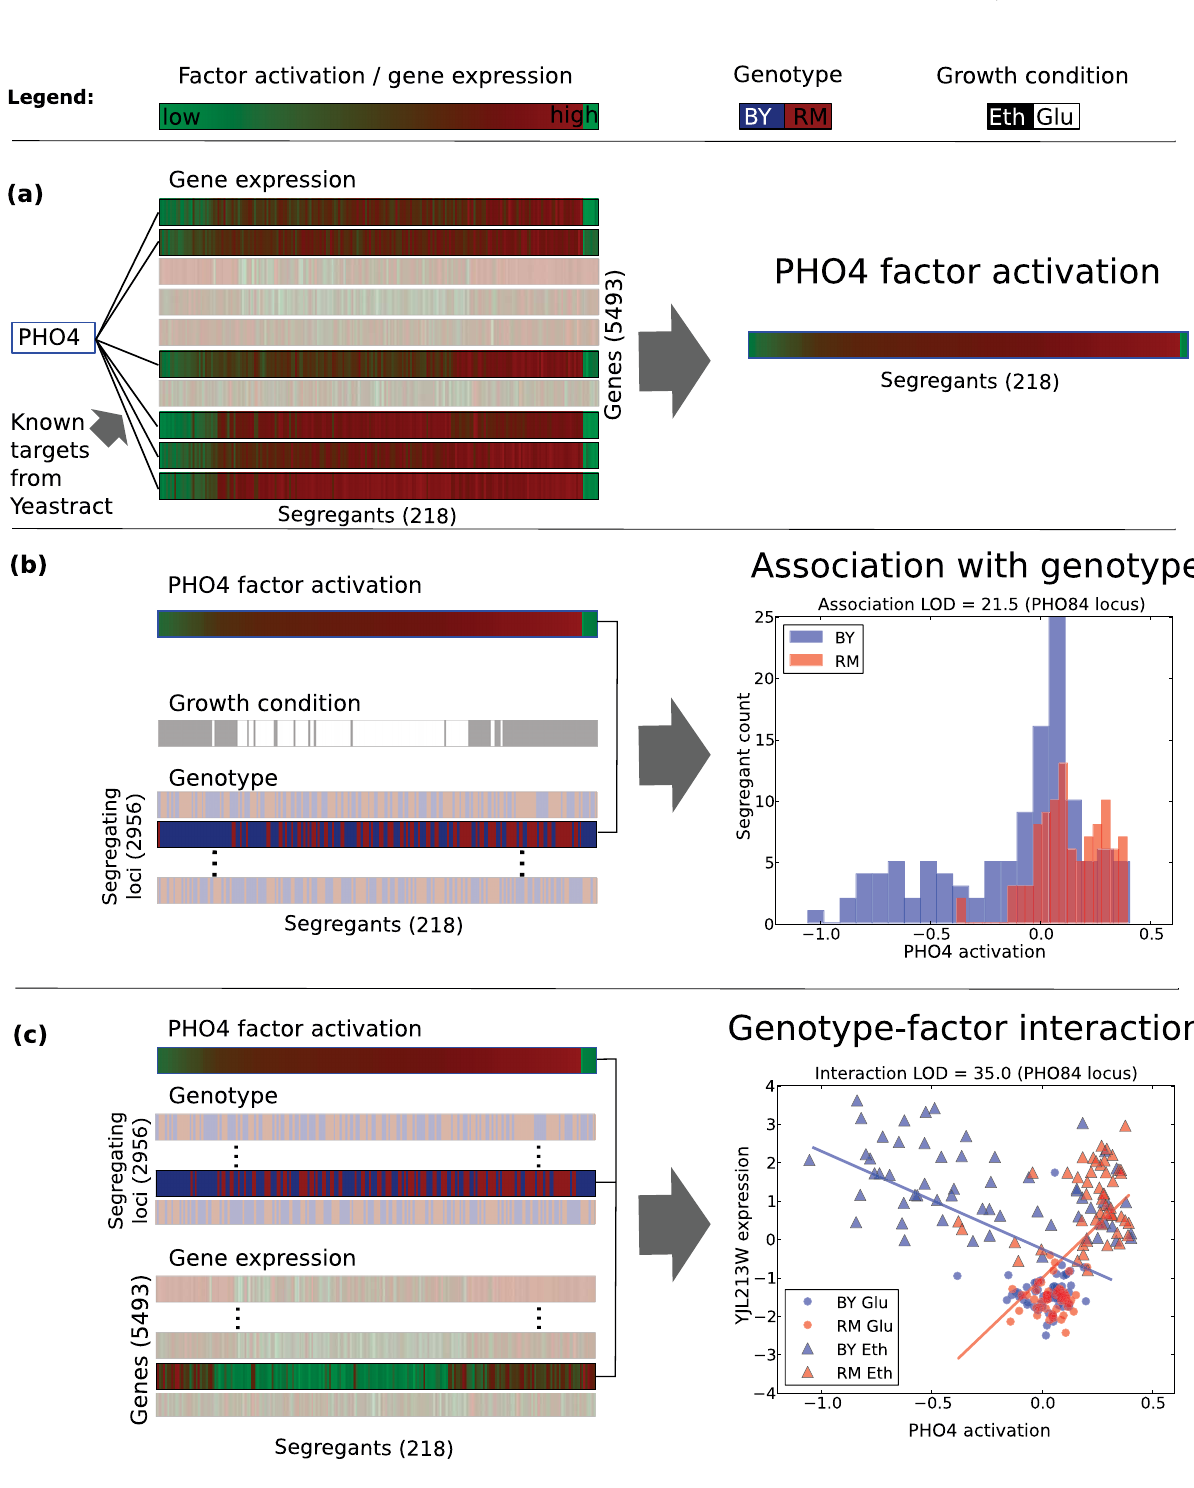
Figure 1. Analysing genetic effects in the context of intermediate phenotypes using PHO4 as an example. (a) Intermediate phenotypes are learnt from expression levels using prior information from Yeastract database on the targets of the factor. The highlighted genes are known targets of PHO4 . These activations are learned jointly for all factors. (b) The variation in intermediate phenotypes can be explained by locus genotypes or the growth condition of the segregants. For most loci (greyed out), the genotype is uncorrelated with the factor activation level. For the PHO84 locus at chrIII-46084, not greyed out and indicated by arrow, it is correlated. The plot at right shows the distribution of factor activations stratified by genotype at this locus. (c) Some genotypes show a statistical interaction with the inferred intermediate phenotype affecting gene expression levels, in this case YJL213W. See also Figure 2.